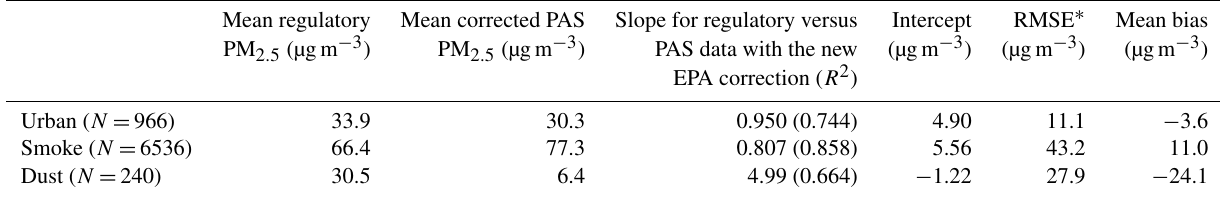
Table 4. Relationship between hourly regulatory PM 2 . 5 and corrected PAS PM 2 . 5 with the new EPA algorithm. Data are included for all simultaneous measurements for the 50 identified events in Part I. ( N gives number of hours of data of each